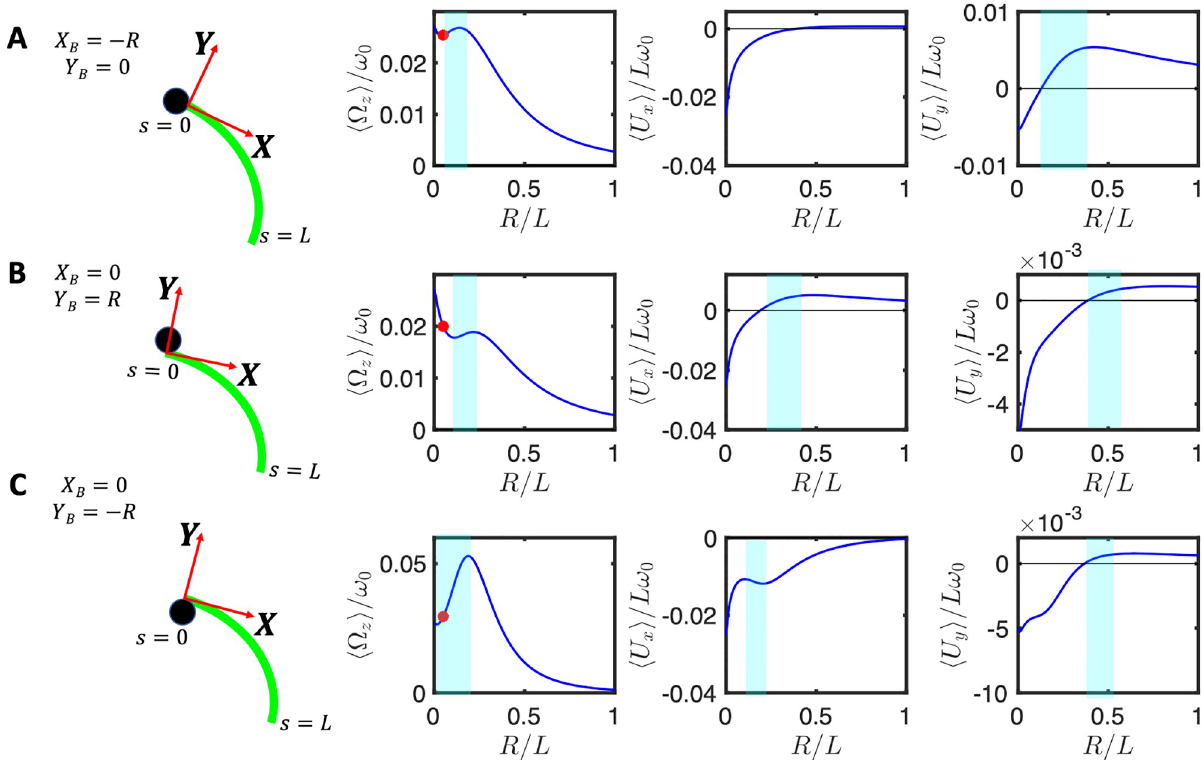
Fig 8. Experimental beat pattern presented in Ref. [14] (see S6 Video) are used to calculate rotational and translational velocities of an axonemally-propelled bead attached (A) symmetrically at Y X B = 0. Anomalous propulsion regimes are highlighted in cyan color. Red circles mark the experimental bead size of R / L * 0.05and the corresponding rotational velocities. Note that the trend observed in panel A is consistent with the trend predicted by our analytical calculations with a simplified waveform for a symmetric bead-axoneme attachment as shown in Fig